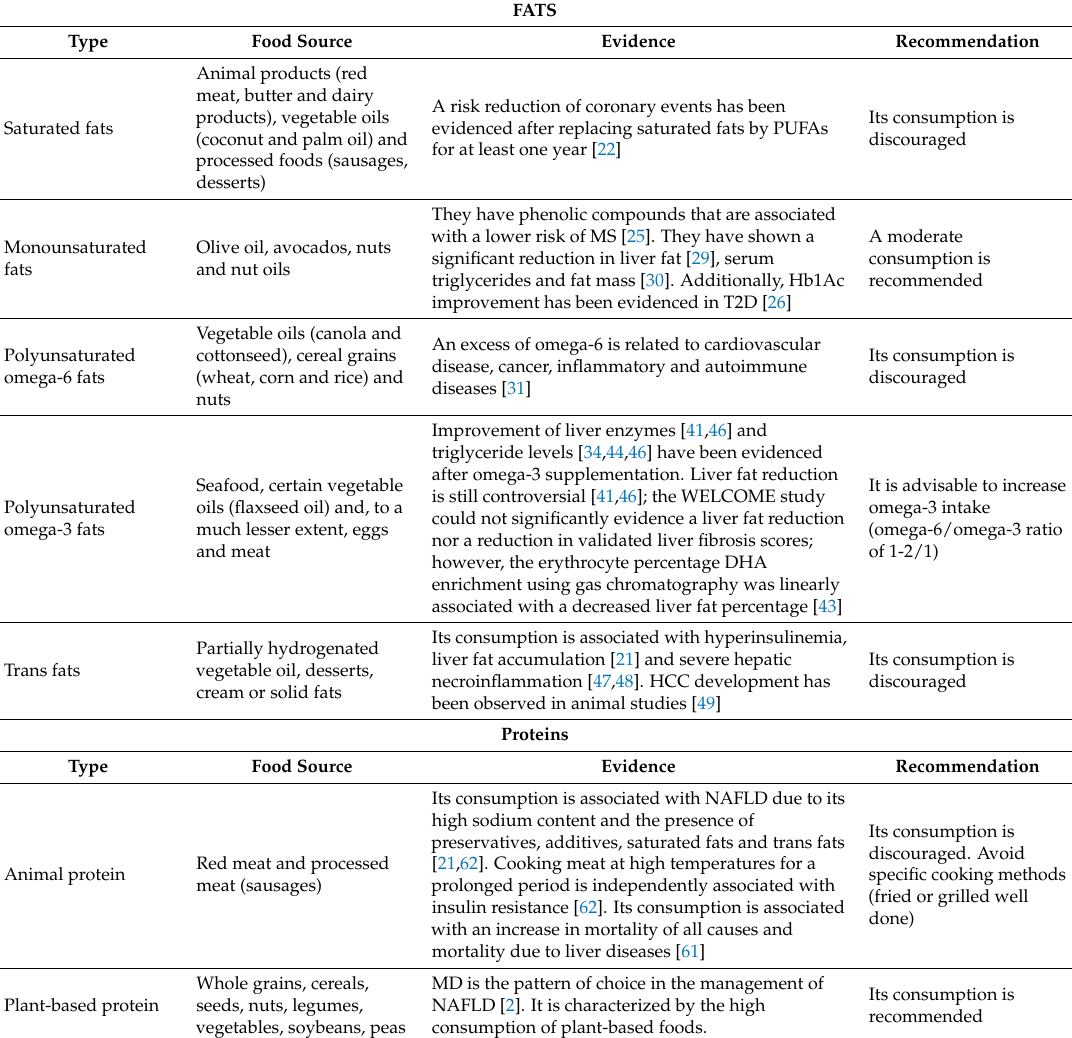
Table 2. The macronutrient recommendation for the treatment of